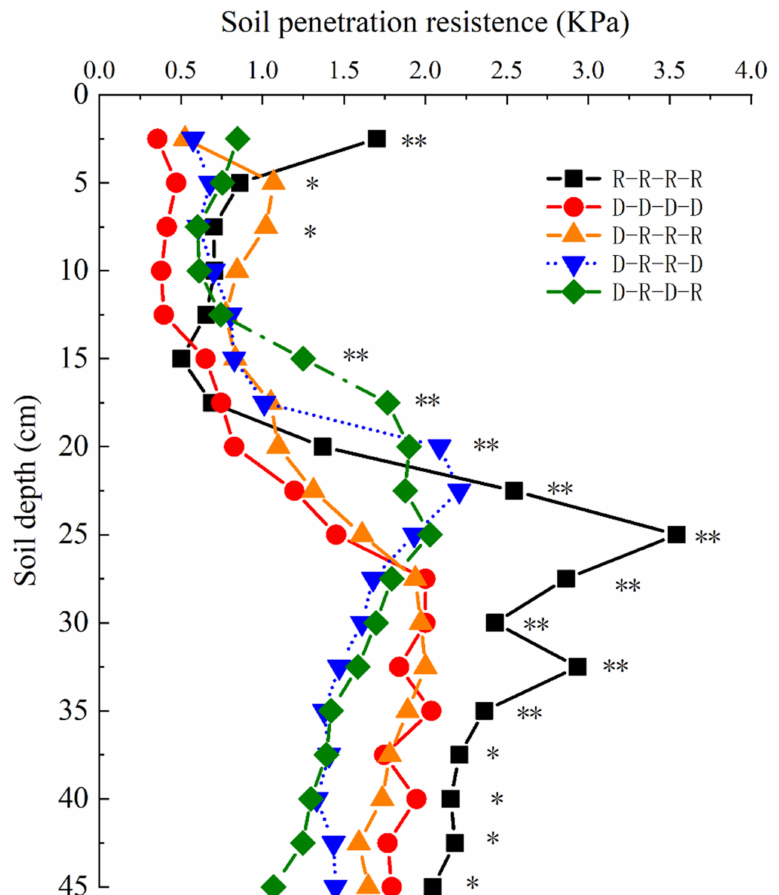
Figure 3. Soil penetration resistance (kPa) for different treatments along the top 45 cm soil layer measured at the seedling stage of winter wheat in 2019 (R representing rotary tillage, D representing deep tillage, and their arrangements representing the different combinations in each year. LSD test: * mean significant differences at 0.05 level, ** mean significant differences at 0.01 level). Table 5. Soil nutrient contents and stratification rates for different treatments sampled after maize harvesting in 2019.